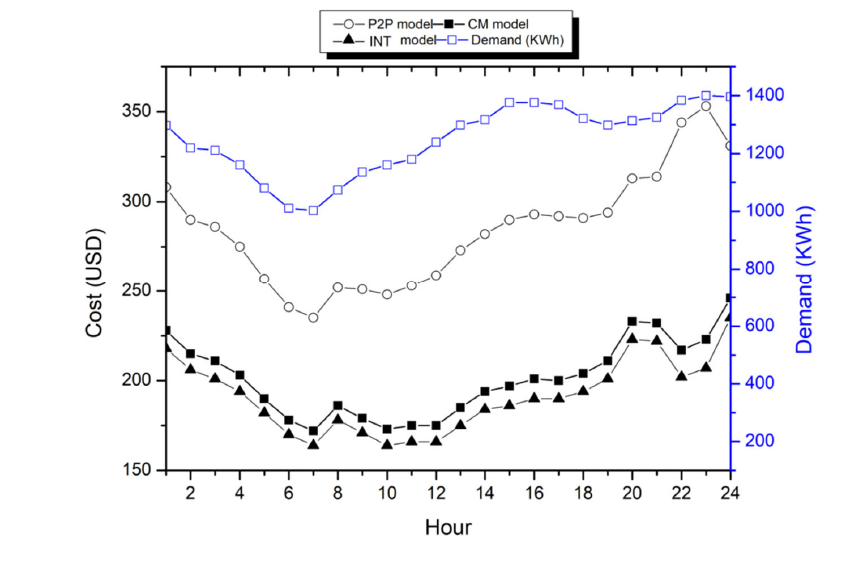
Fig. 9 . Comparison of hourly cost among three